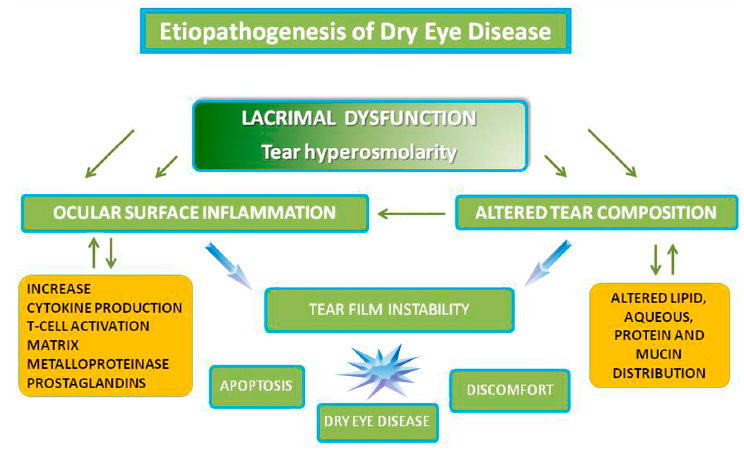
Figure 3. Etiopathogenesis of Dry Eye Disease.